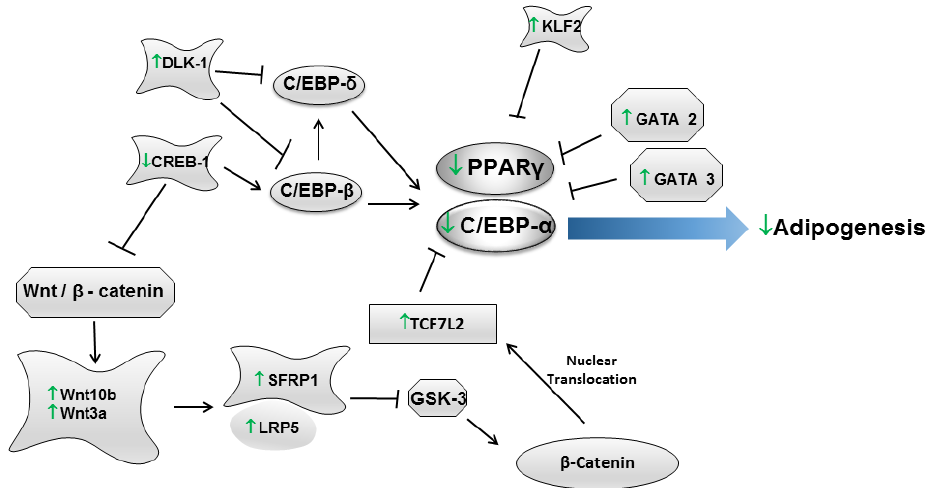
Figure 1. In vivo and in vitro effects of yerba maté in